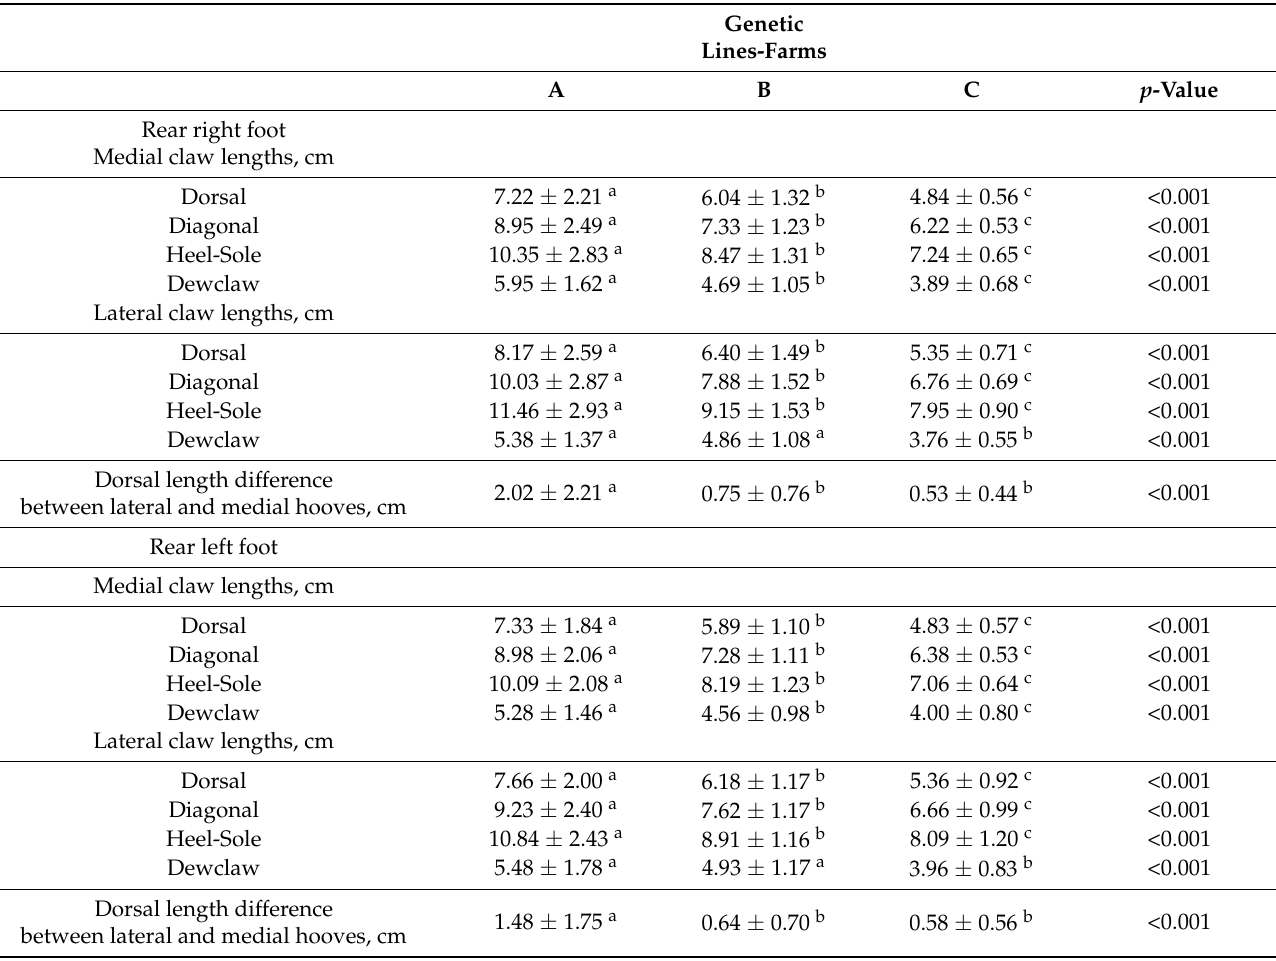
Table 3. Claw lengths: Dorsal, the distance from the dorsal skin-horn junction (periople) to the apex of the toe; Diagonal, the distance from the apex of the toe to the skin-horn junction at the heel; Heel–Sole, the length of the abaxial wall (sole) and bulb (heel) that are in contact with the floor surface from the top of the toe to the caudal end of the heel; Dewclaw (along dorsal wall from just below the coronary band to the end of the wall); Dorsal length difference between lateral and medial hooves, expressed as mean ± SD of culled sows’ rear feet from three pig farms (A, B, C). The sows of each farm belonged to different genetic lines (Farm A: PIC; Farm B: Danbred; Farm C: